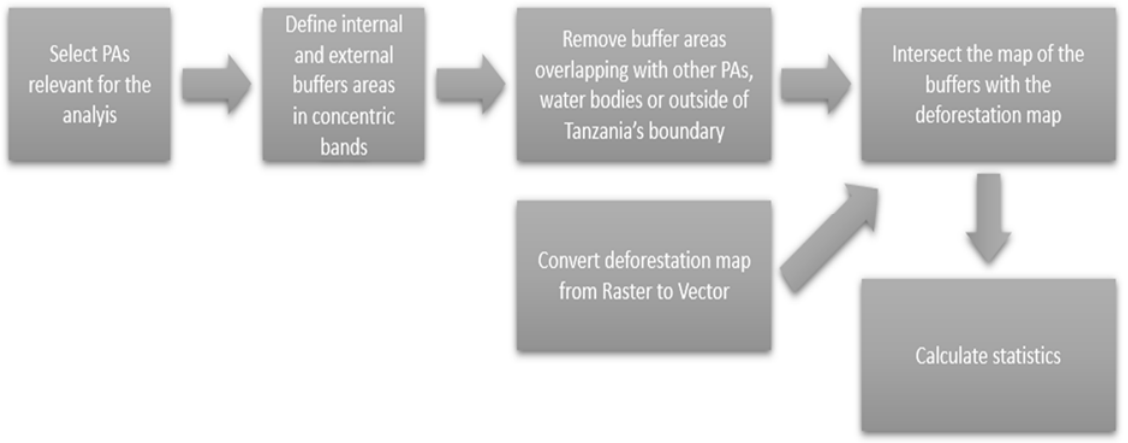
Figure 2. Work flow diagram in ArcGis for the simultaneous construction of concentric bands and extraction of data and output to worksheet.